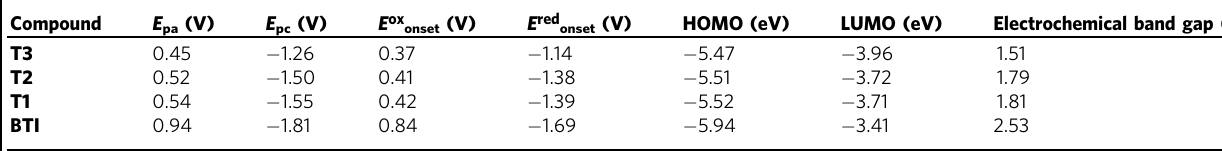
Table 1 Electrochemical data performed in dichloromethane, using the tetrabutylammonium hexa fl uorophosphate (Bu 4 NPF 6 ) as supporting electrolyte.